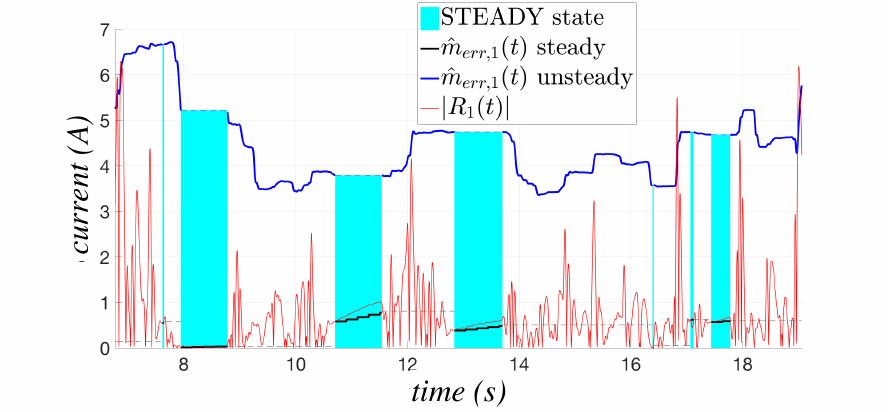
Figure 3. Comparison between ˆ m err ,1 ( t ) computed for the steady state and for unsteady ones.